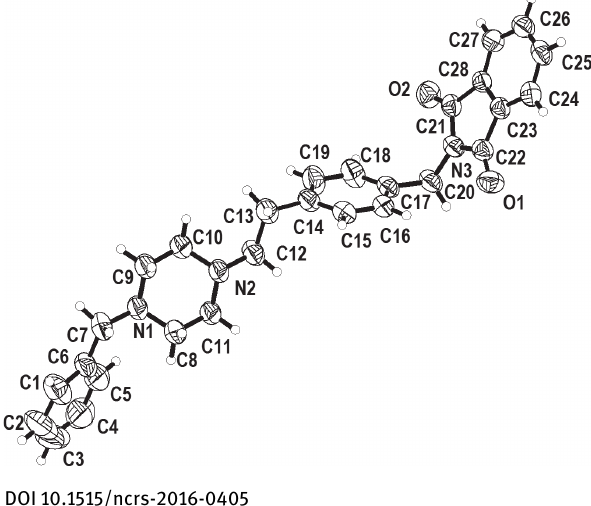
Table 1: Data collection and handling.